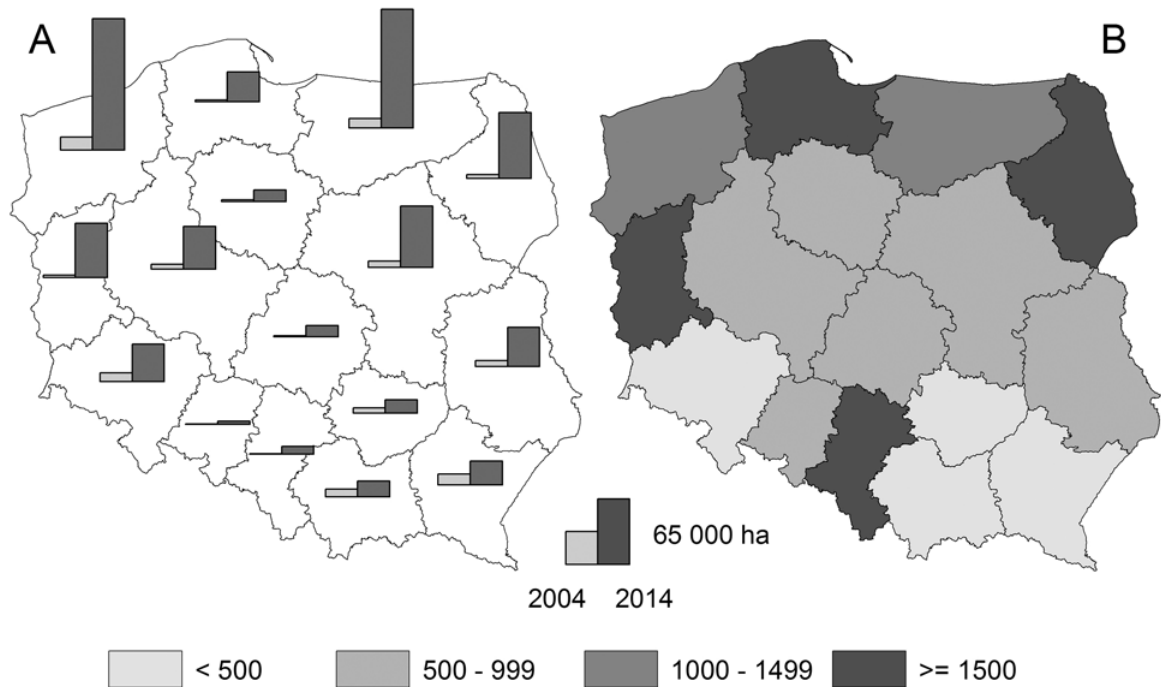
Fig. 8. Area of (A) and changes in (B) the number of organic farms in Poland by voivodeship, 2004–2014 (2004 = 100).